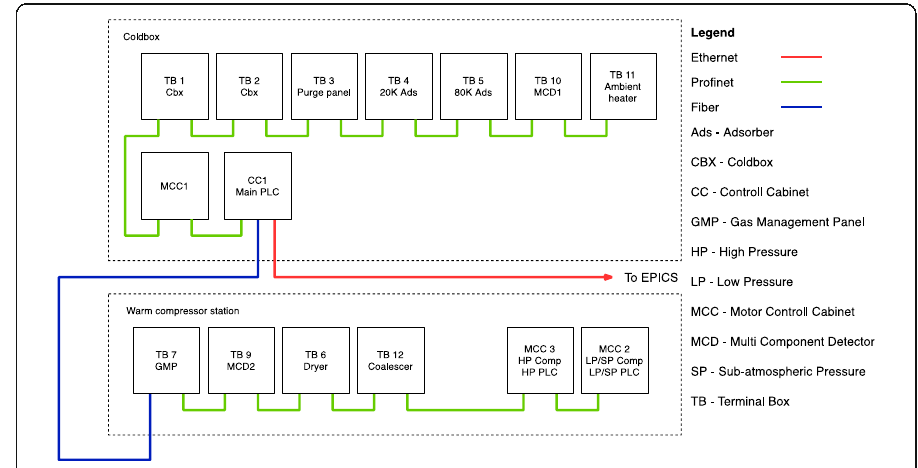
Fig. 3 Simplified control systems architecture